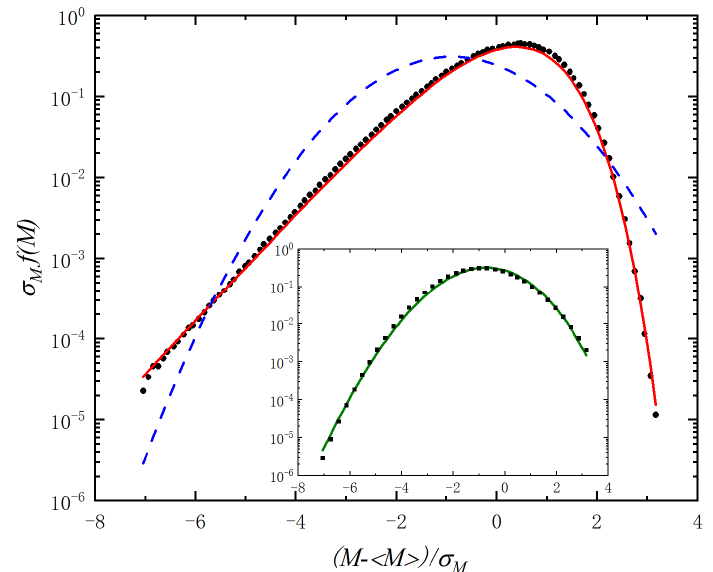
Figure 8. Comparative analysis of typical experimental data from the classical literature. Dots for experimental data, solid line for fitting of the WJ distribution and dashed line for fitting of the Gaussian function. Inset: Square solid points representing the Gaussian function obtained from the fit of the data and green solid line for the result of its refitting by the WJ distribution.